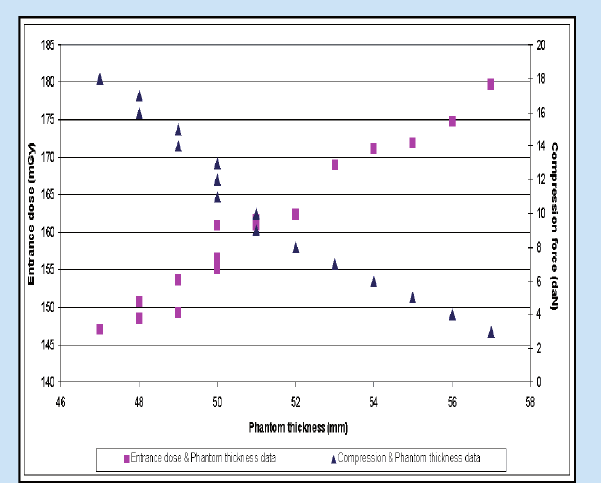
Fig. 3. IQF scoring demonstrating the geometry effect, compression force and image quality relationship. Fig. 4. Entrance dose and compression